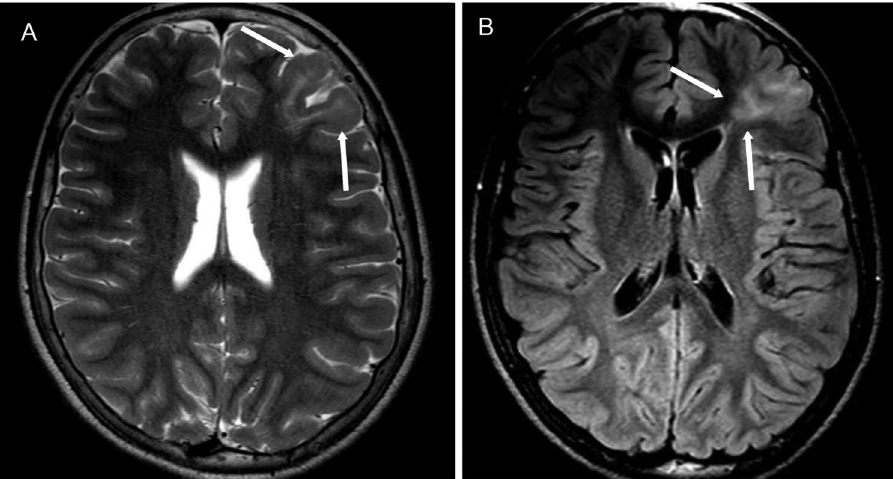
Figure 3 - A typical MRI of focal transmantle cortical dysplasia in a 34-year-old woman. A) A coronal T2-weighted image demonstrating focal hyperintensity and the thickening of the right frontal cortex with a loss of demarcation between the gray and white matter (white arrow). B) A coronal T2 FLAIR showing a band of abnormal signal intensity extending from the cortex to the lateral ventricle (white